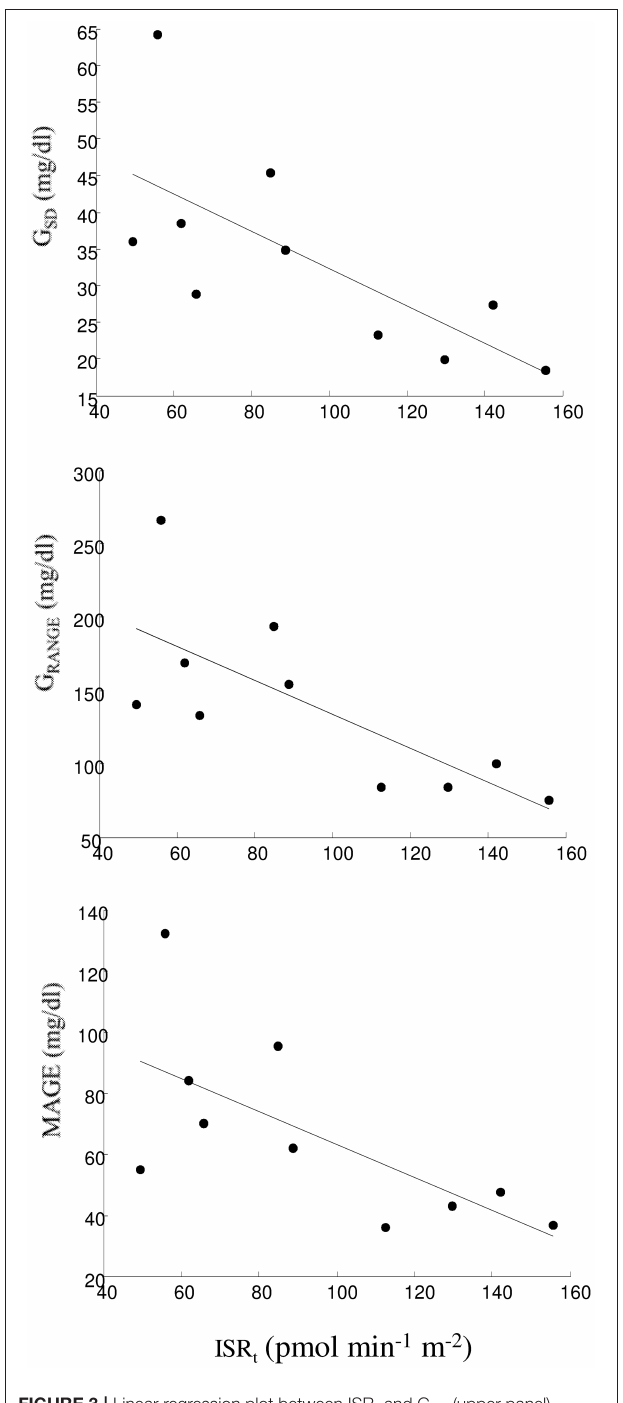
FIGURE 3 | Linear regression plot between ISR t and G SD (upper panel), G RANGE (intermediate panel), and MAGE (lower